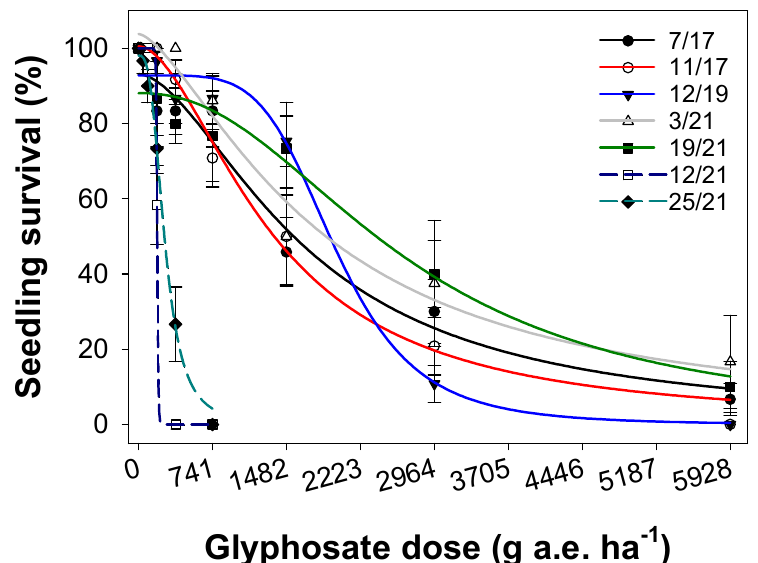
Figure 3. Effect of glyphosate dose on survival of seven populations of Chloris virgata . The most susceptible population was 12/21. Plants were sprayed at the four–five leaf stage of each population.